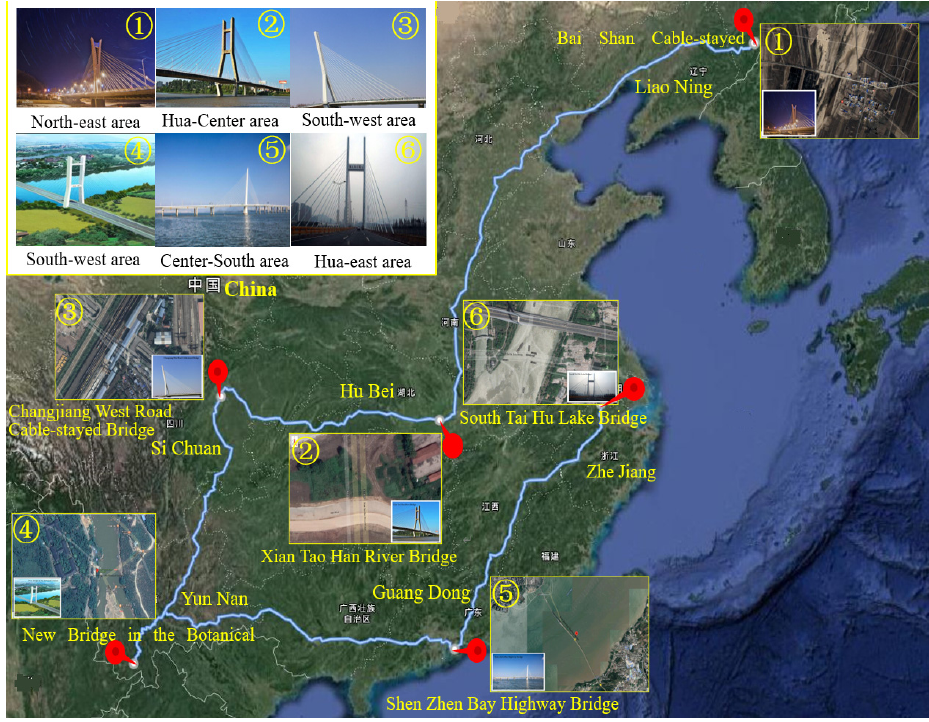
Figure 3. Schematic diagram of cable-stayed bridge regional distribution [83].